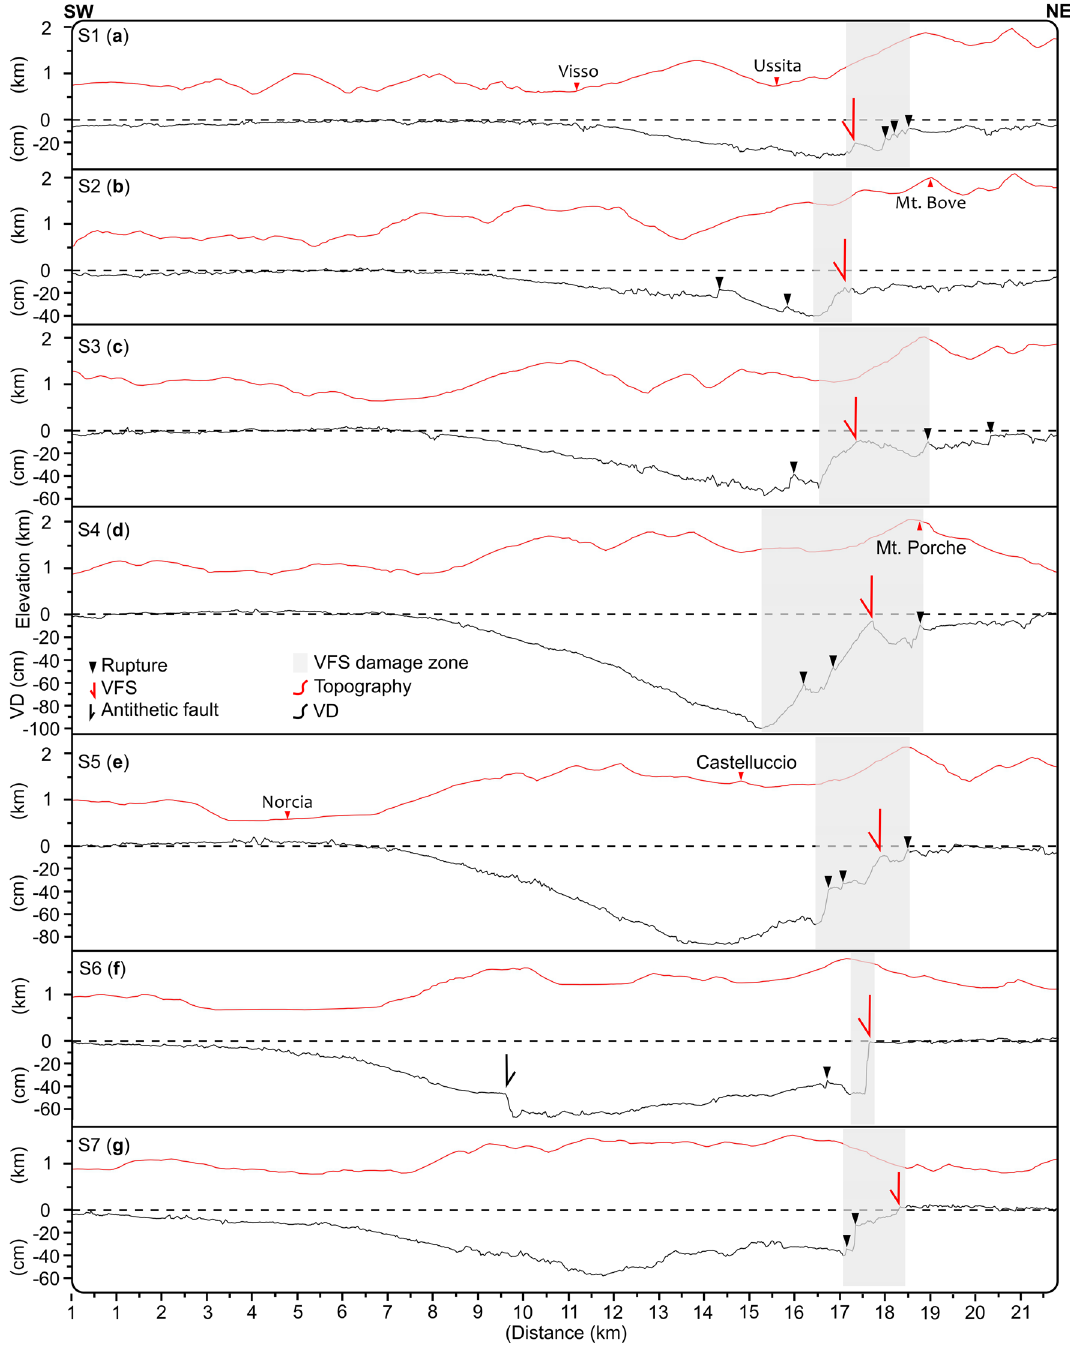
Figure 3. VDM1 cross-sections. Seven representative cross-sections showing the vertical displacement (VD, in black), and the topography (in red). The grey areas represent the zones affected by deformation close to the VFS. The VFS, the antithetic fault, the VD and the ruptures have been derived from the VDM1. Vertical exaggeration of the VD = ×